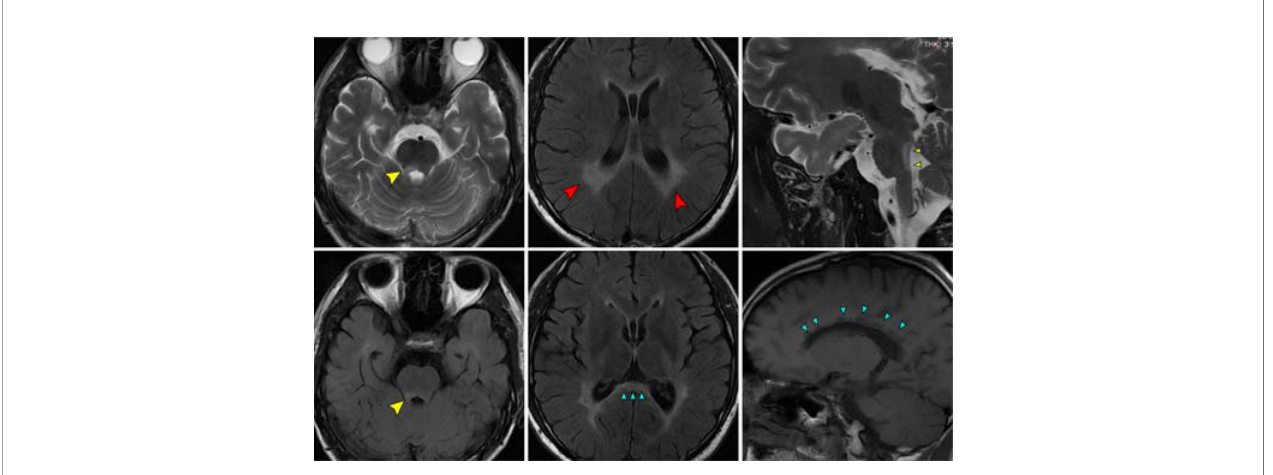
FIGURE 2 | The patient ’ s MR images which mimicking NMOSD.